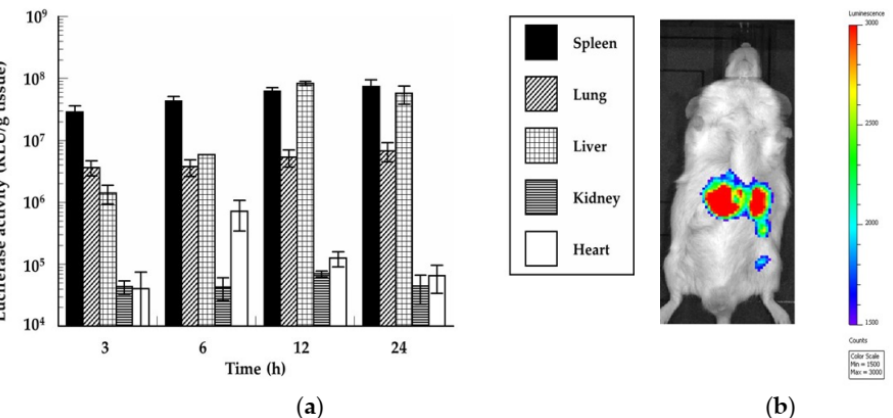
Figure 9. Protein expression of the mRNA/PEI8/ γ -PGA12 complex containing 40 µ g mRNA in mice after intravenous administration. ( a ) Luciferase activities in the liver, kidney, spleen, heart, and lung were determined by chemiluminescence. Data represent the mean ± S.E. ( n = 4–8). ( b ) Light emission to the outside of the body was measured using an in vivo imaging system at 24 h after mRNA/PEI8/ γ -PGA12 complex administration.